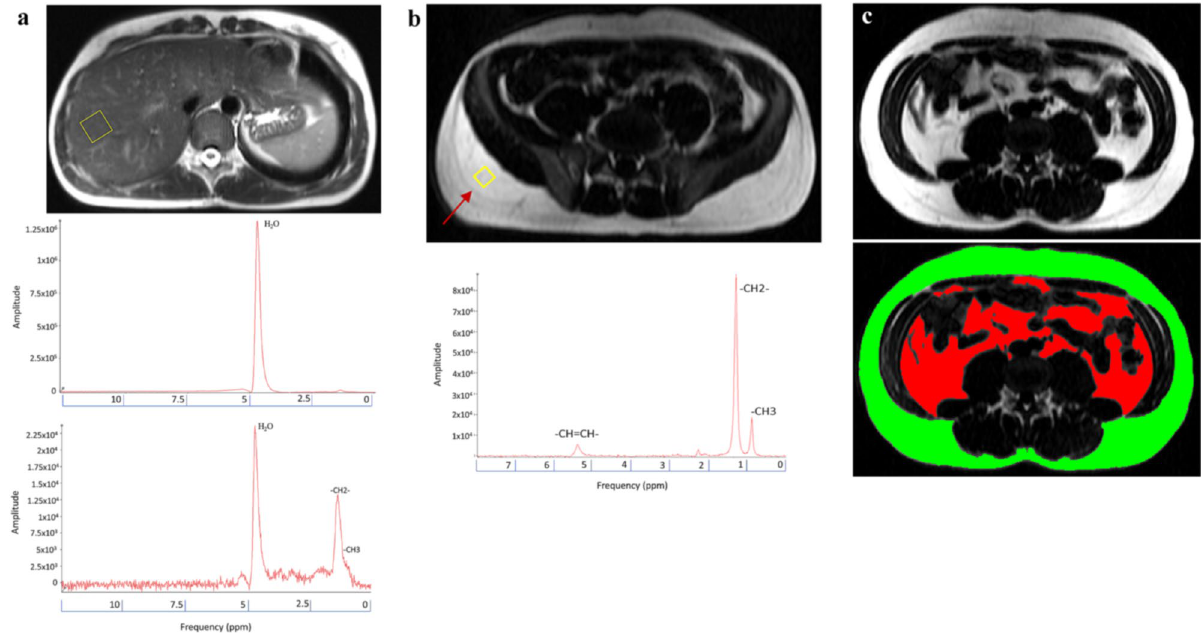
Figure 2. T1 weighted abdominal MR images for volumetry and magnetic resonance spectroscopy (different subjects). ( a ) A view of the positioning of the voxel (yellow box) for hepatic magnetic resonance spectroscopy avoiding large vessels and bile ducts. Spectra are displayed as with and without water suppression with a TE of 30 ms. H 2 O: water protons, –CH2: methylene protons, –CH3: methyl protons. ( b ) A view of the positioning of the voxel (yellow box) for magnetic resonance spectroscopy of subcutaneous abdominal adipose tissue depot. Care was taken to position the voxel away from Scarpa’s fascia (arrow). Spectra were collected with a TE of 200 ms. –CH = CH–: olefinic protons/double bond resonance, –CH2–: methylene protons, –CH3: methyl protons. ( c ) A Sliceomatic slice with visceral abdominal adipose tissue (red) and subcutaneous abdominal adipose tissue